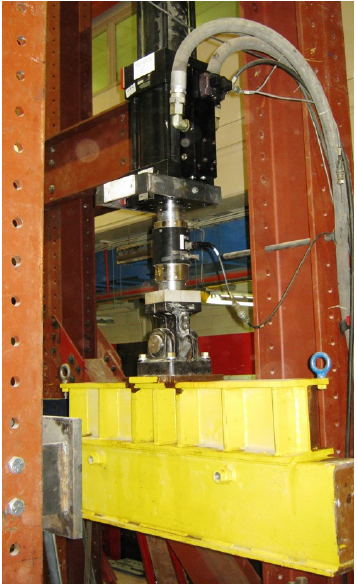
Figure 1. Spreader beam (in yellow) attached to a hydraulic actuator (in black and